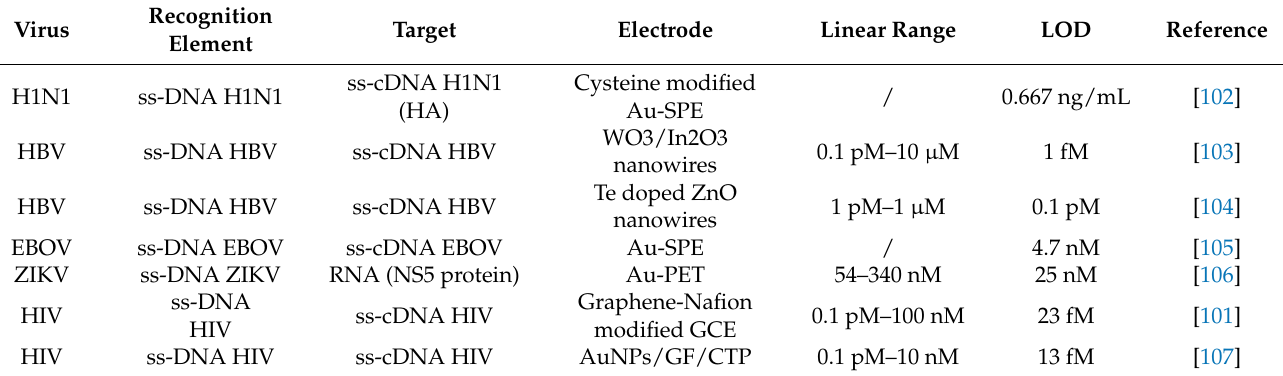
Table 1. Recently developed genosensors for virus